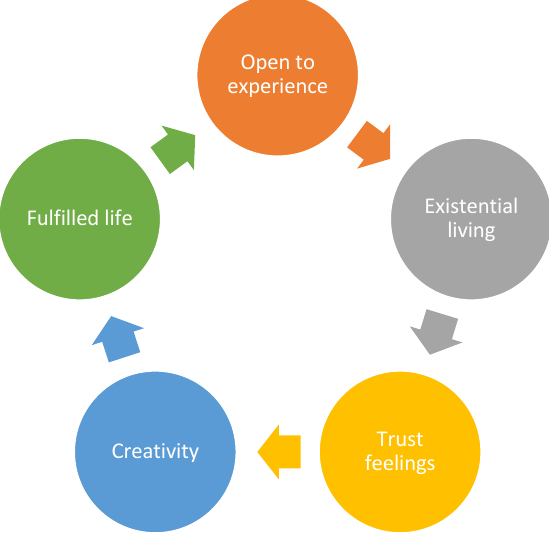
Fig. 6. The 5 Characteristics of the Fully Functioning Person by Rogers